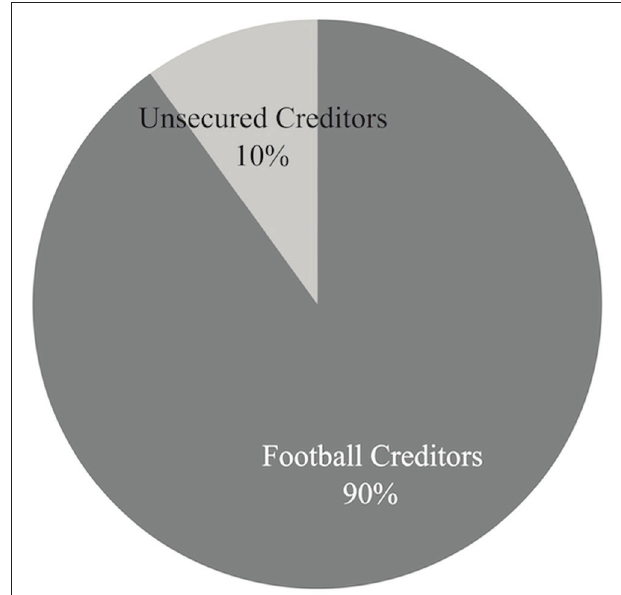
Figure 2: Crystal Palace (2010) Payment Allocation.